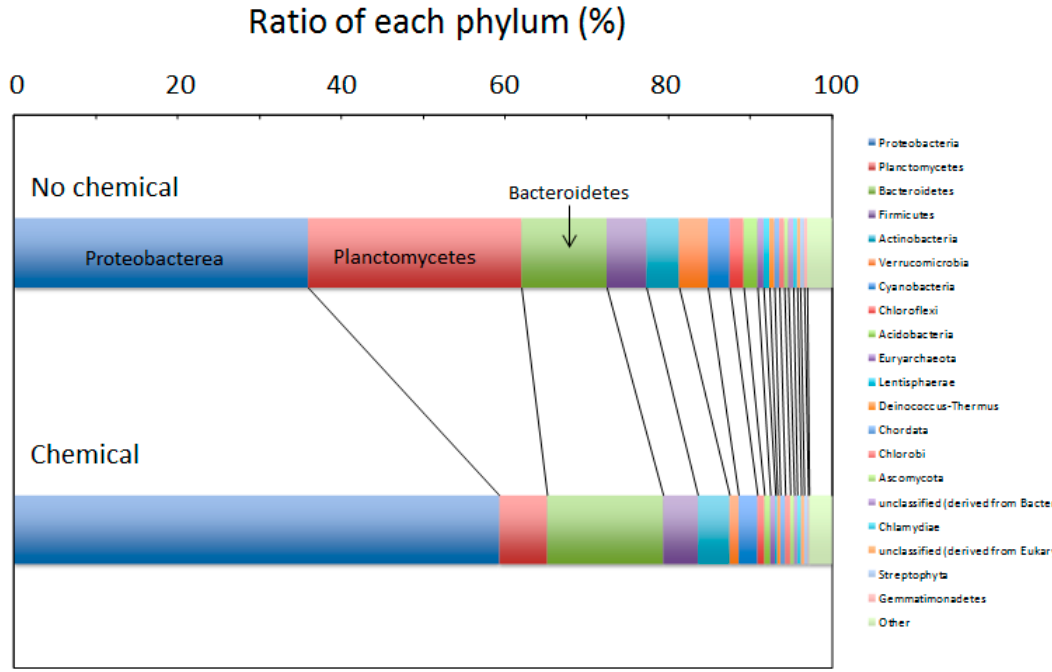
Figure 8. Microbial community structure of RO foulants at the Phylum level.